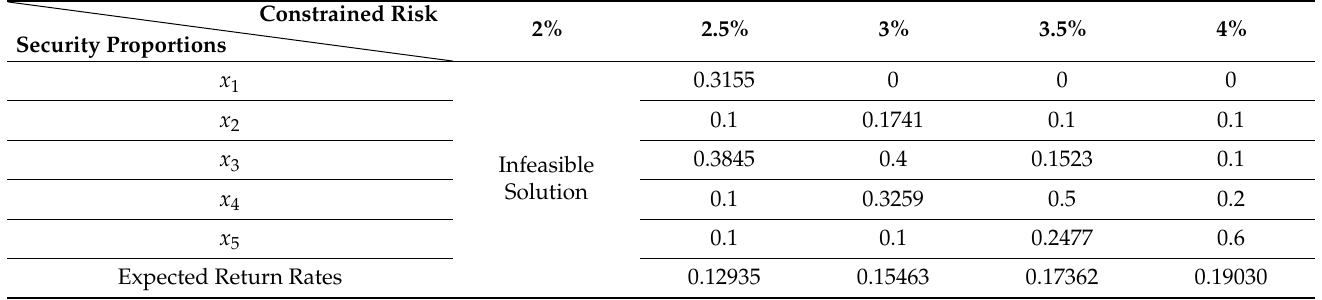
Table 13. The dimension with t = 2 and s = 3 with a guaranteed return rate (cid:101) p 1 in the proposed model.